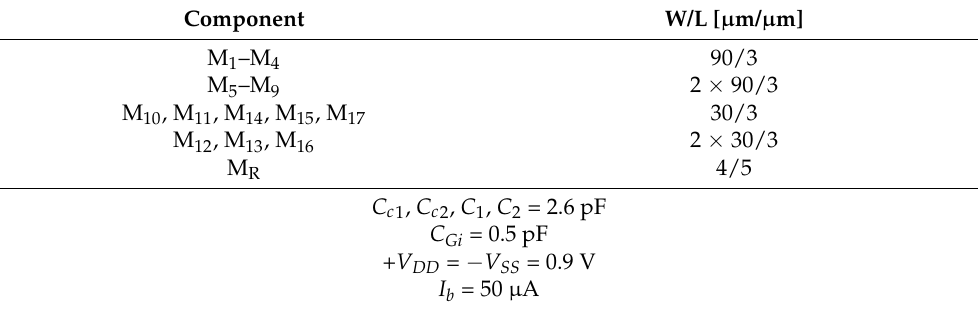
Table 1. Transistor aspect ratios and component